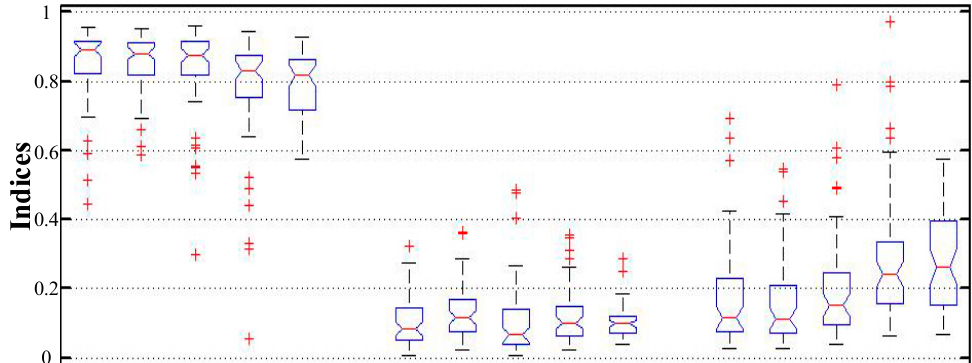
Figure 9. Quantitative validation of pulmonary fissure segmentation on the LOLA11 dataset using different methods. Here, the F1, FDR, FNR indices of five different methods are plotted from left to right, and the subscripts m5 and m4 represent the proposed method with the parameter n=5 and 4. The subscripts od, d and f indicate the ODoS filter [14], DoS filter and fissureness filter [7], respectively.